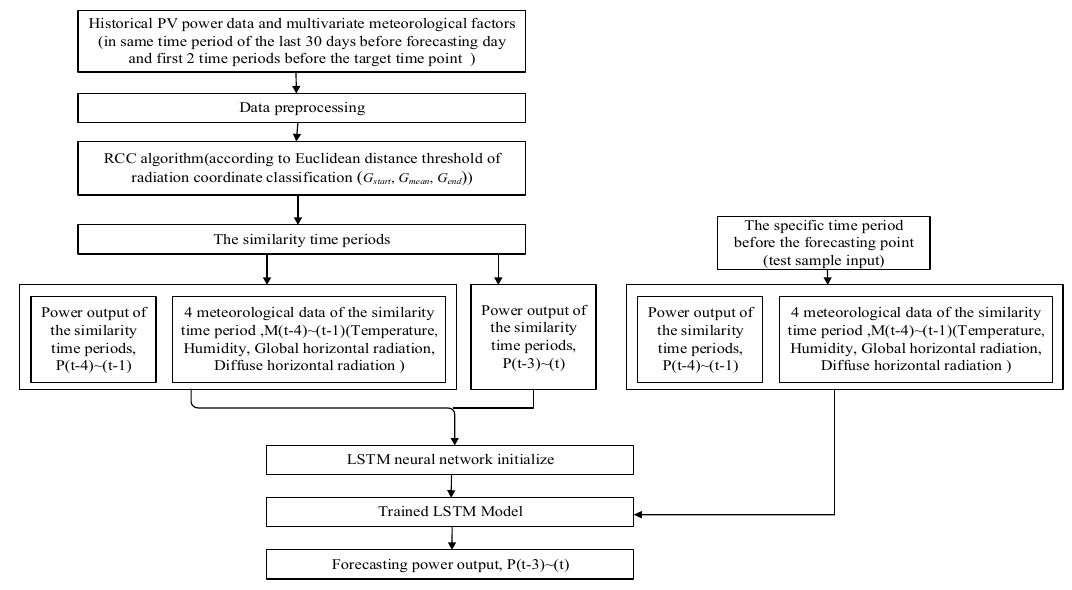
Figure 8. The implementation procedure of the proposed model.